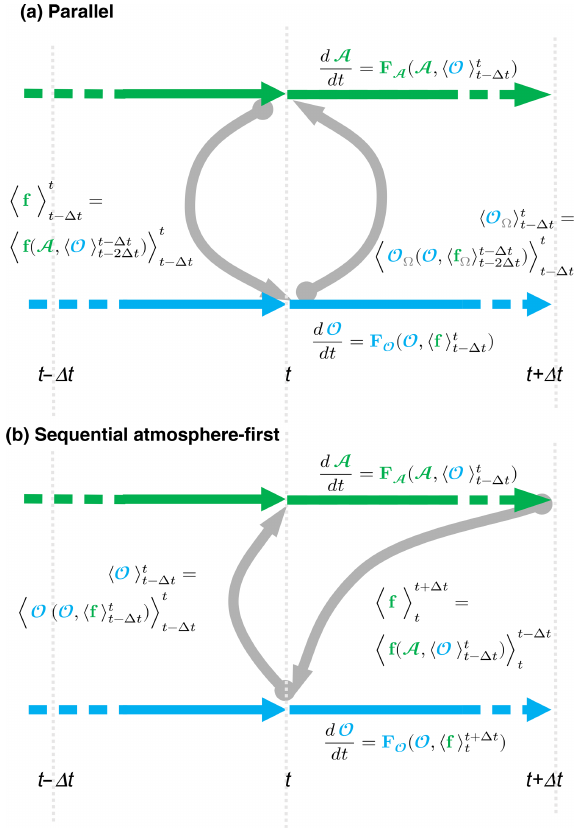
Figure 1. Time stencil of the exchanges between the ocean and the atmosphere in the lagged algorithms. (a) The parallel algo- rithm, redrawn from Fig. 5.4 of Lemarié (2008). (b) The sequential atmosphere-first